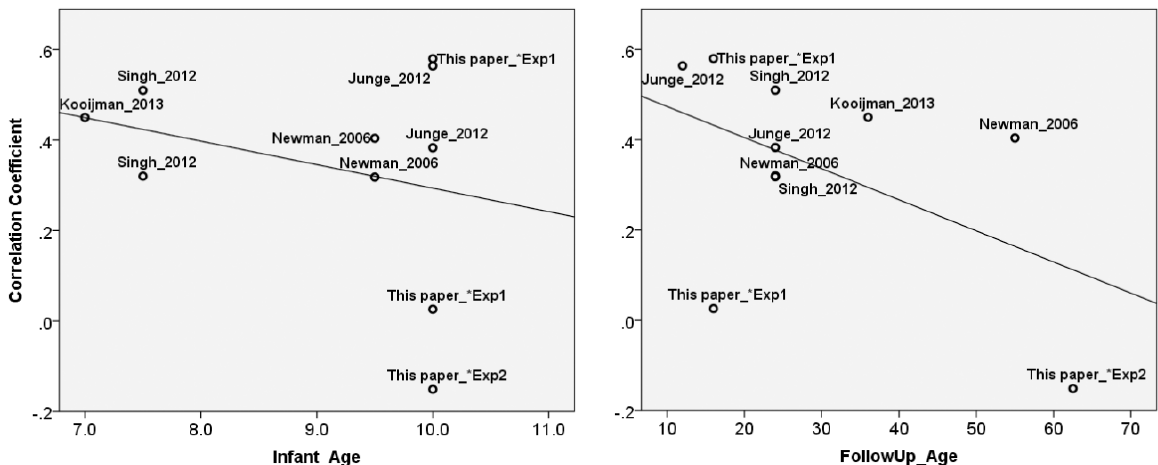
Figure 5. Scatterplots with correlation coefficients between infant speech segmentation ability and future language profiles plotted on Y-axis as a function of infant age ( left ), and of age at follow up ( right ). Labels next to data points refer to the studies from which they were obtained; some studies reported multiple effect sizes. Note that for event-related potentials (ERP) studies, the polarity of the correlation coefficient has been reversed to allow for comparison with the head turn preference (HTP) studies: a positive correlation indicates that the observed correlation conforms to the